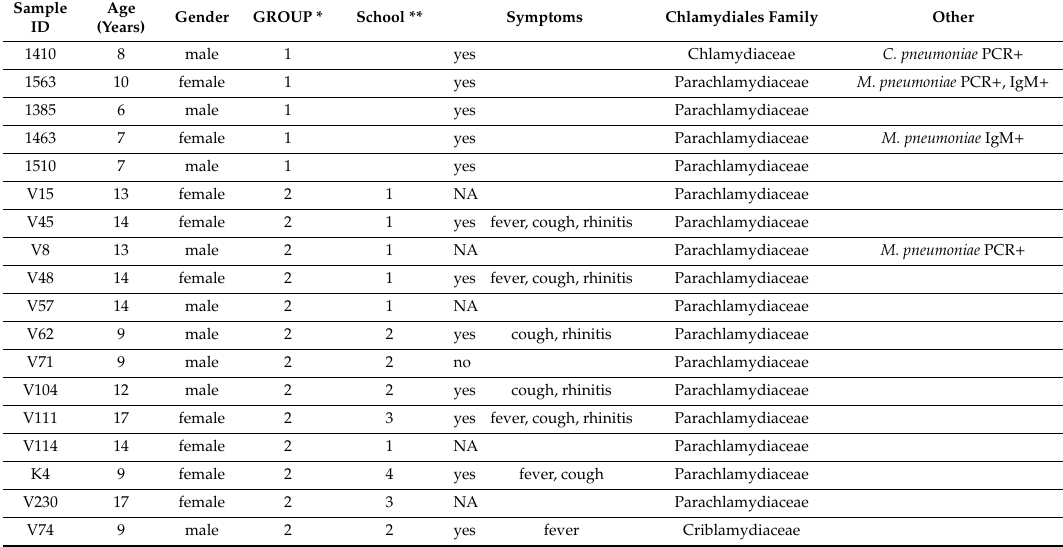
Table 2. Samples containing Chlamydiales